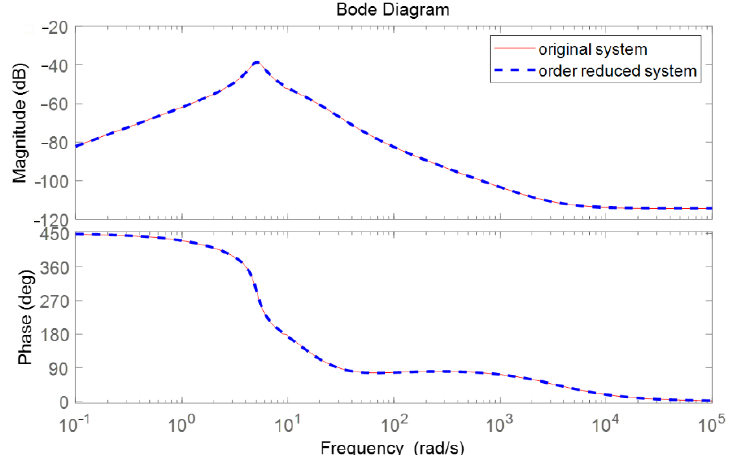
Figure 11. Bode diagram comparison of the order reduced system and original system of active power control loop.